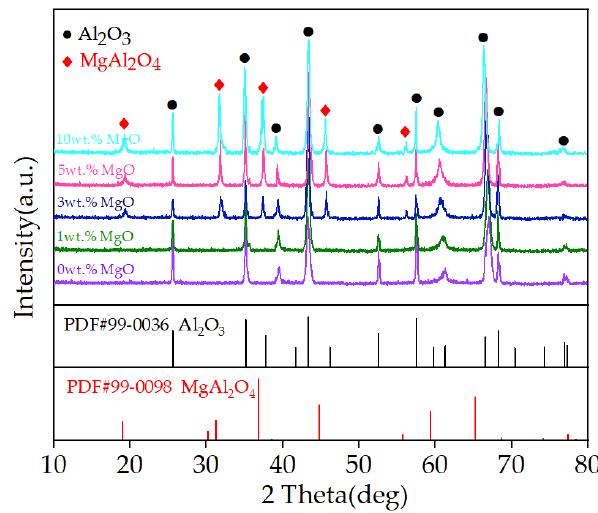
Figure 7. XRD patterns of Al 2 O 3 coating with different MgO doping contents.